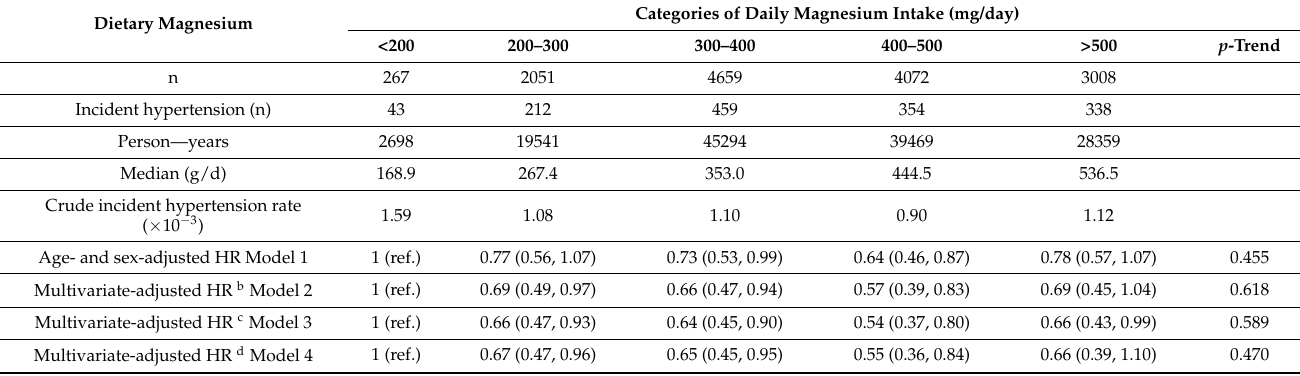
Table 3. Association between magnesium intake and incident hypertension among participants in the SUN (“Seguimiento Universidad de Navarra”) cohort, 1999–2016 a